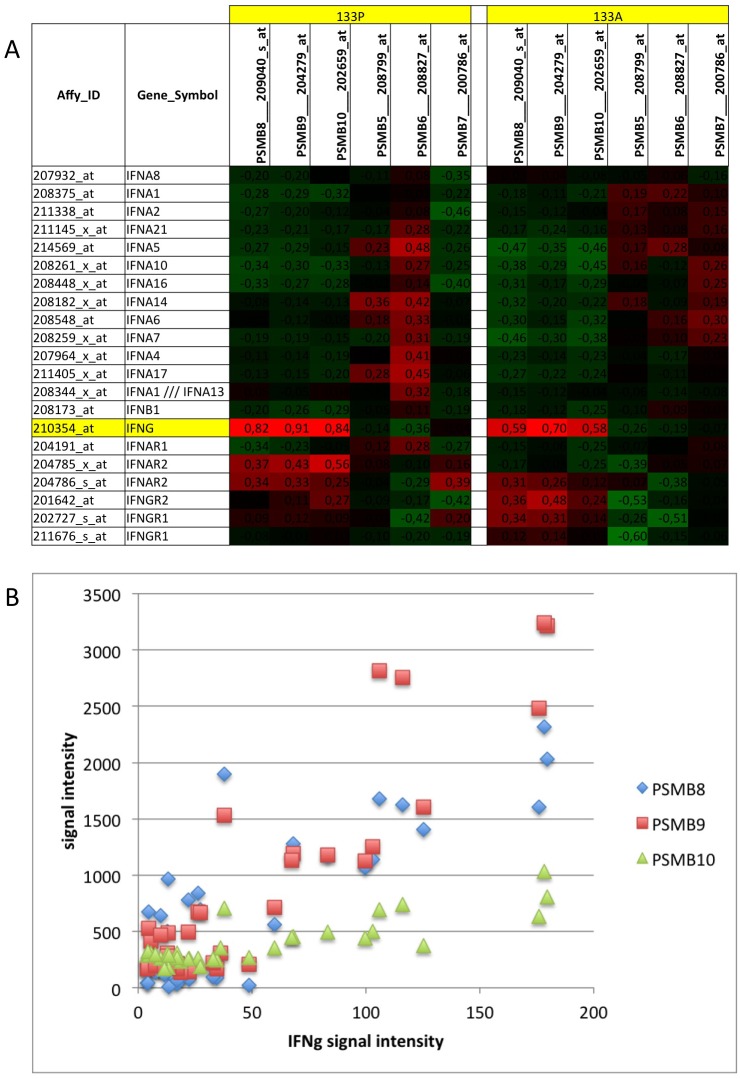
Correlation of immunoproteasome with IFN and IFNR expression in myositis muscle tissue:Transcriptome data referenced in table S2 were re-investigated. A) Correlation analysis was performed for 133P and 133A datasets independently. Only IFNγ revealed high correlation coefficients with PSMB8, PSMB9 and PSMB10. The corresponding constitutively expressed subunits PSMB5-7 were not or even negatively correlated. B) Comparing the association of IFNγ with PSMB8, -9 and -10 for each sample individually, the increase was much higher for PSMB8/-9 compared to PSMB10 as described before (figure 6).